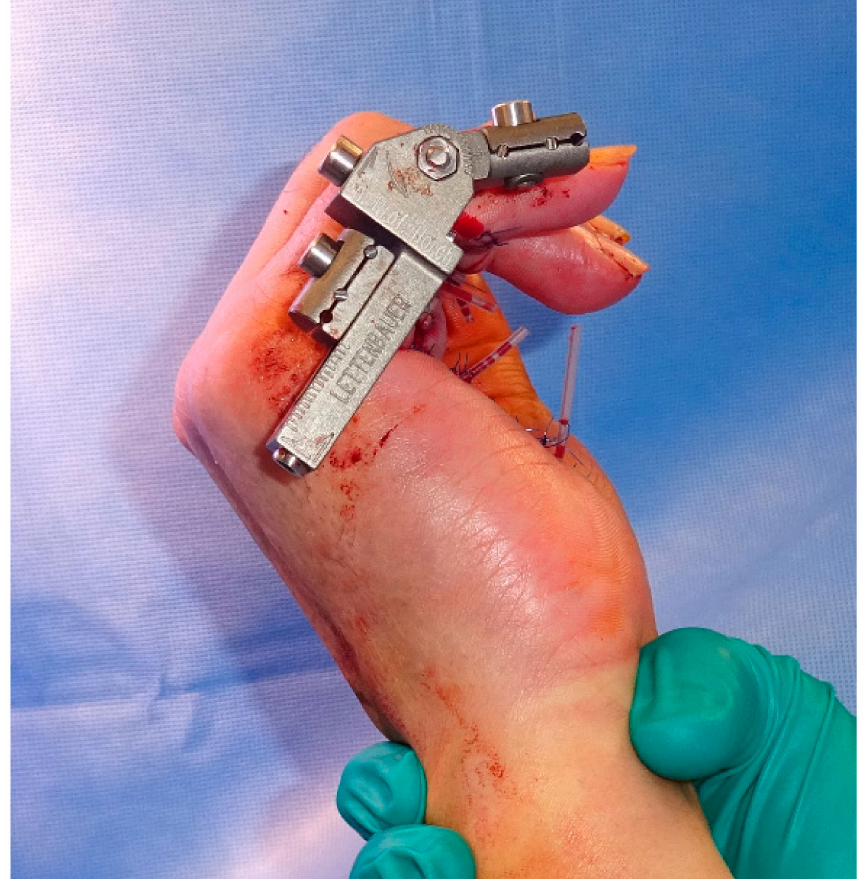
Figure 7. Intraoperative application of the skeletal distraction device in combination with